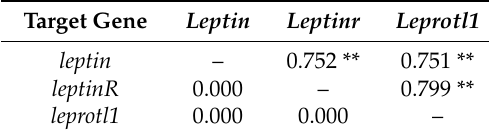
Table 2. The correlation coefficients among leptin , leptinR and leprotl1 expression in the different development stages of M. amblycephala gonad. Target Gene Leptin Leptinr Leprotl1 leptin – 0.752 ** 0.751 ** leptinR 0.000 – 0.799 ** leprotl1 0.000 0.000